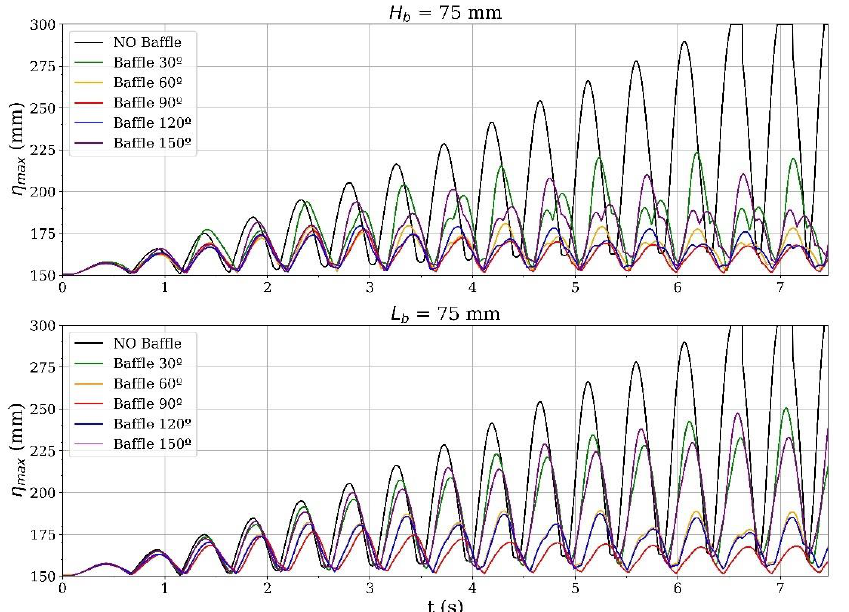
Figure 6. Maximum free surface elevation through time, that is, the height of the wave through the simulation time.